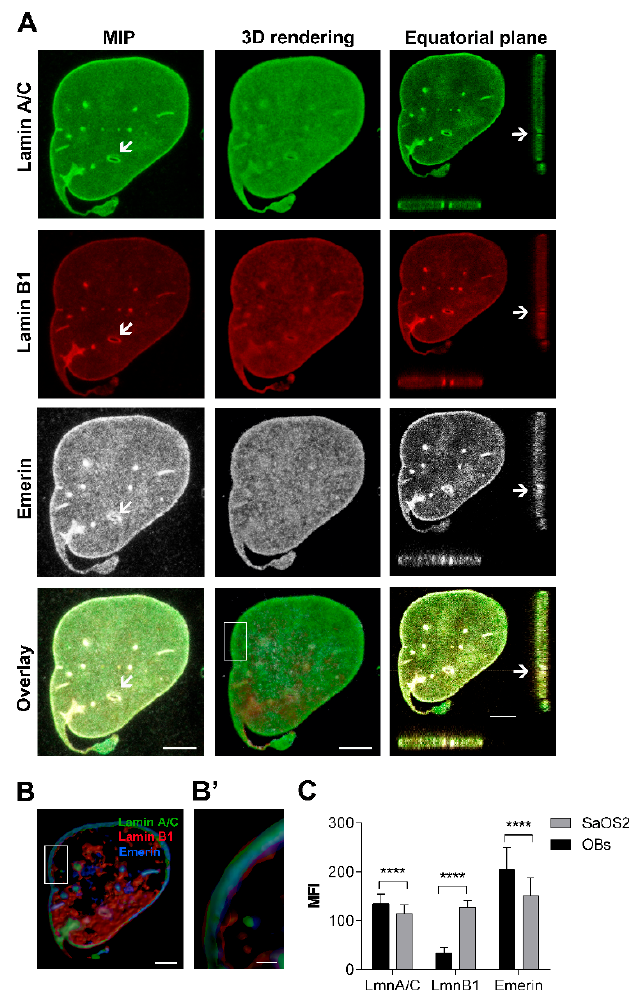
Figure 3. Behaviour of lamins and emerin, and nuclear morphology in SaOS2 cell line. ( A ) Maximum intensity projection (MIP) of series of z-stacks images covering the entire nucleus (left column), 3D rendering in blend volume mode (central column, LAS X 3D software, Leica Microsystems, Wetzlar, Germany), and XZ- and YZ-axes projections performed in the central focal plane of the nucleus (right column) are shown. The main morphological nuclear alterations as foci, folds, blebs and channels (arrow) are found in SaOS2 cells. Bars: 5 µ m. ( B ) 3D rendering in the focal central plans of the nuclear rim in surface volume mode (Imaris software). Bar: 4 µ m. ( B’ ) High magnification of the 3D rendering of the boxed area showing the di ff erential expression of lamins (in green and red) and emerin (pseudocoloured in blue). Bars: 1 µ m. ( C ) Mean Fluorescence Intensity (MFI) of lamins and emerin immunoexpression in SaOS2 cells, in comparison to normal OBs. ****: p < 0.001.